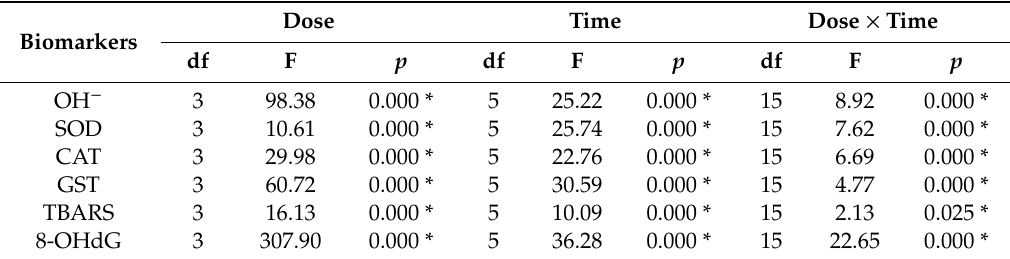
Table 1. Two-way ANOVA result for biomarkers in earthworms exposed to sulfoxaflor. Dose Time Dose × Time Biomarkers